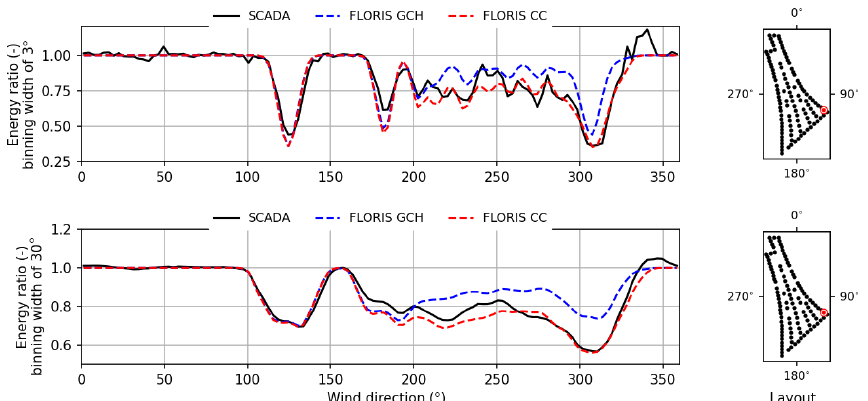
Figure 13. Energy ratio versus wind direction for a turbine located in the southeast region of the Anholt wind farm. The reference turbines to which the energy ratio is normalized are the five closest wind turbines that are operating in freestream flow. The reference wind direction is determined by the nacelle headings from turbines directly neighboring Turbine 86.